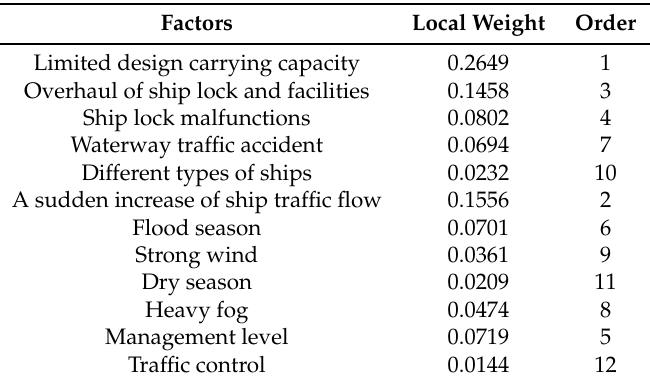
Table 5. Local weights of influencing factors.